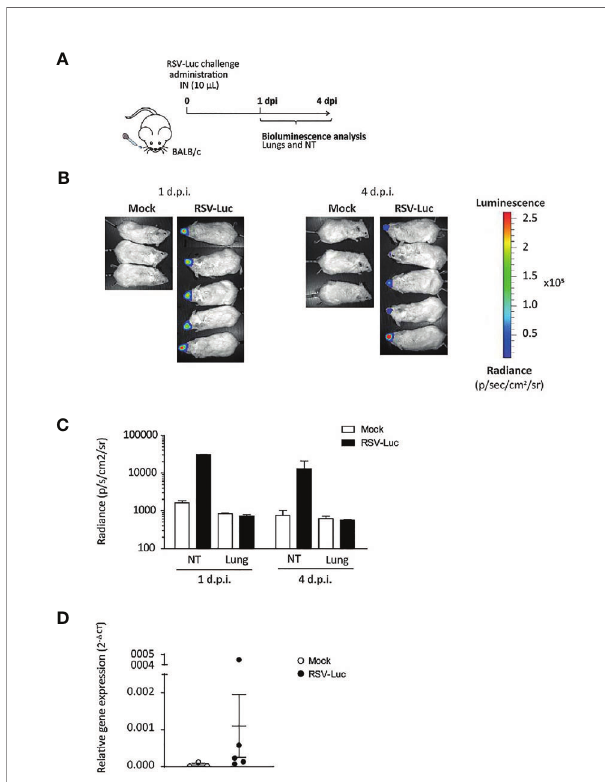
FIGURE 4 | The RSV infection model of the upper respiratory tract. (A) BALB/c mice received intranasally a small inoculum volume (10 µL) of RSV-Luc (1.4 × 10 5 pfu/mice) or mock (supernatant of Hep2 cells) to restrain viral replication to the upper respiratory tract. (B) Bioluminescence was measured at 1 and 4 d.p.i. by intranasal injection of 50 m l of D-luciferin and the capture of photon emission (dorsal view) from the whole animal using the IVIS system. (C) Luciferase activity was measured in NT or lungs homogenates by quanti fi cation of bioluminescence emission (radiance in photon/sec/cm 2 /sr) using “ Living Image ” software after addition of D-luciferin in the lysates. (D) mRNA level of RSV N gene was evaluated by real time RT-PCR in the lungs and expressed with the formula (2 - D Ct ). Data are mean ± SEM from n = 3 mock-infected mice or n = 5 RSV-Luc-infected